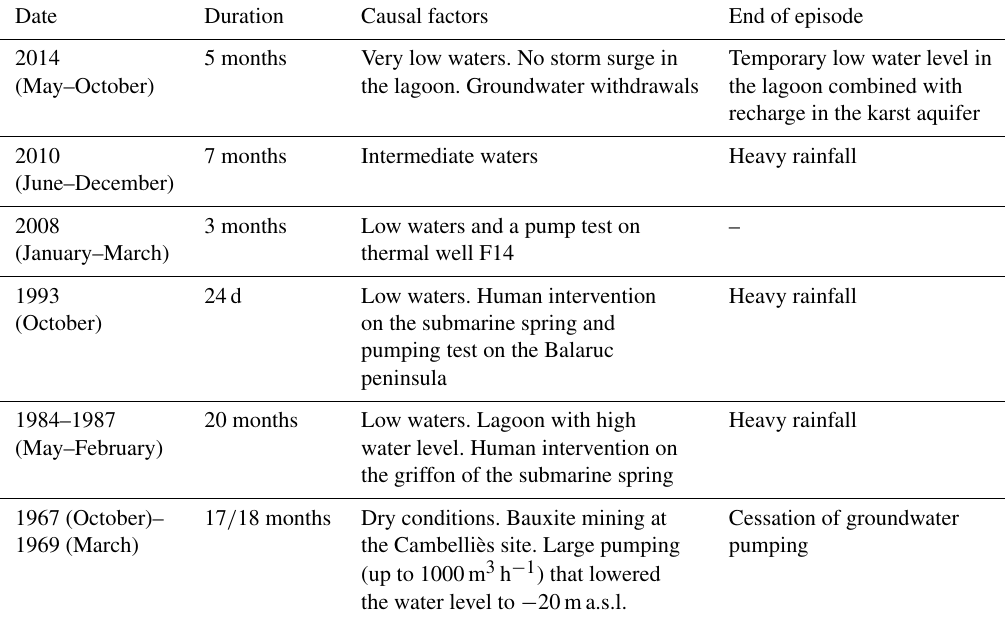
the lagoon. Groundwater withdrawals the lagoon combined with recharge in the karst